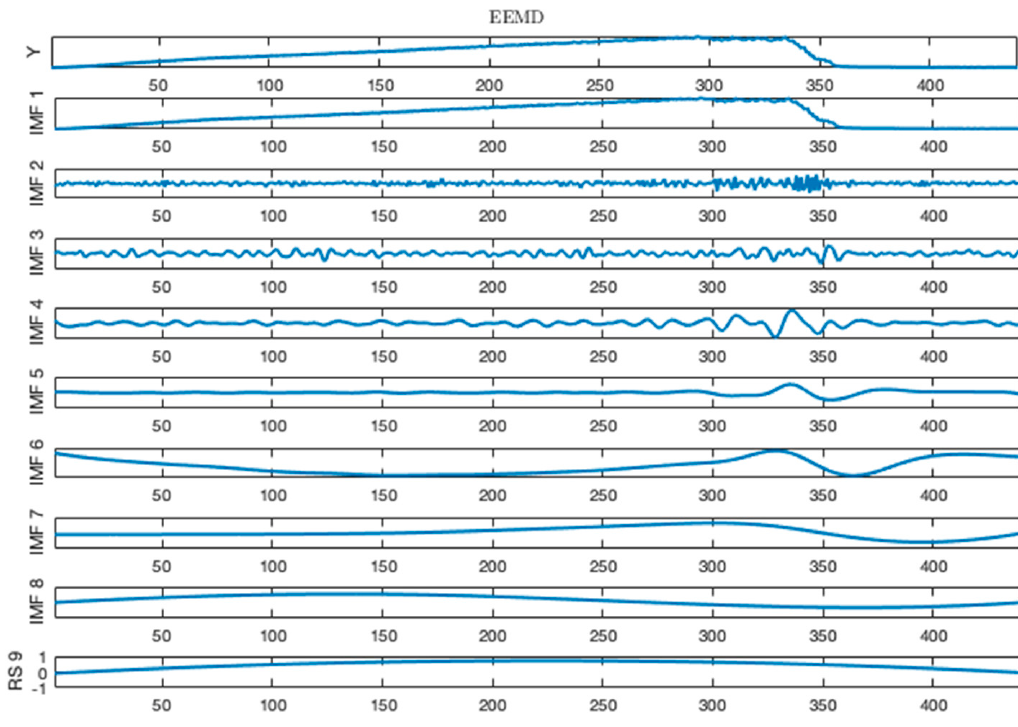
Figure 8. EWT noise reduction of “Yangdong Line.”